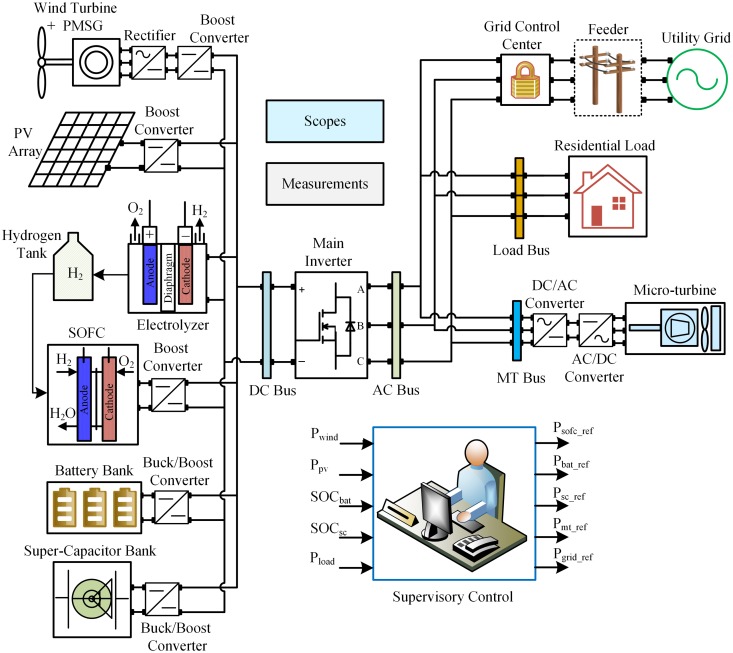
Hybrid power system.